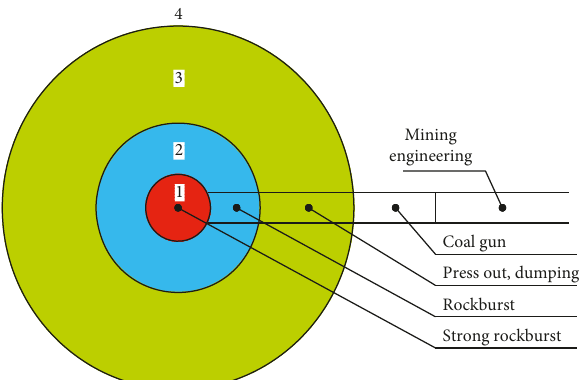
Figure 1: Model of the relationship between rockburst and dy- namic system of coal and rock: (1) dynamic nuclear zone; (2) damage zone; (3) injury zone; (4) influence